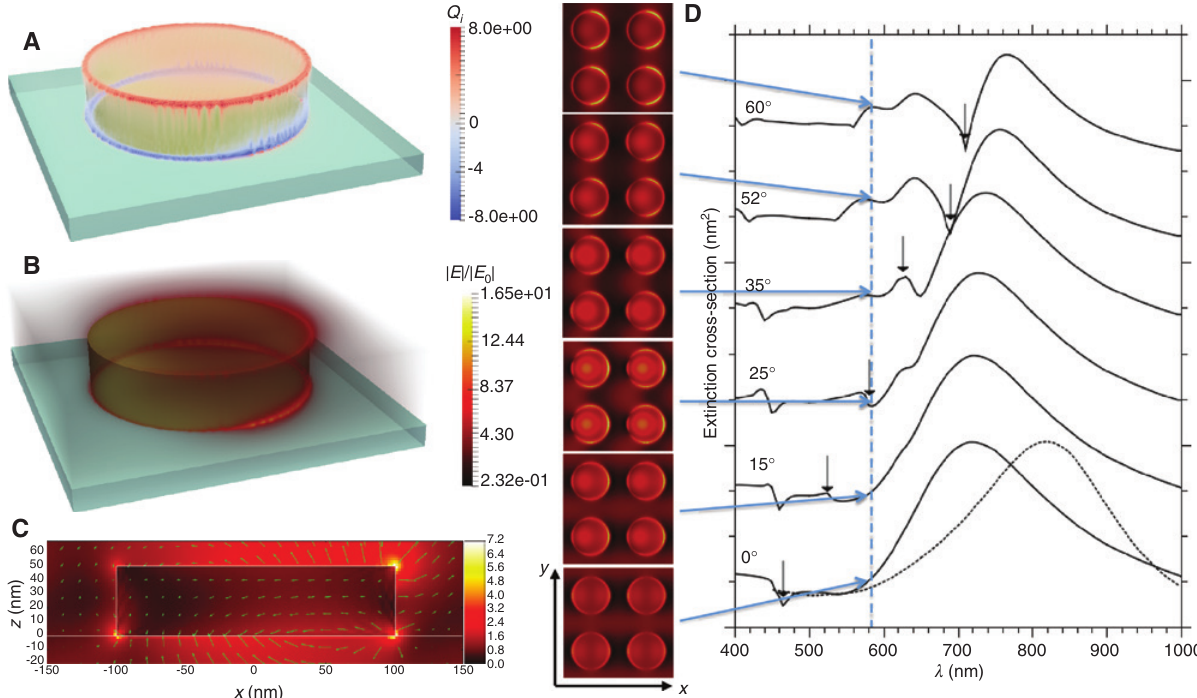
Figure 7: Numerical characterization of the vertical mode. 3D charge (A) and electric field (B) distributions around the single nanoparticle for a TM excitation at 60 ° incidence; field map of the section of the single nanoparticle in the incidence plane (C); evolution of the field maps ~ 570 nm) calculated at the bottom of the nano-cylinders for different incidence angles of related to the vertical mode ( λ V